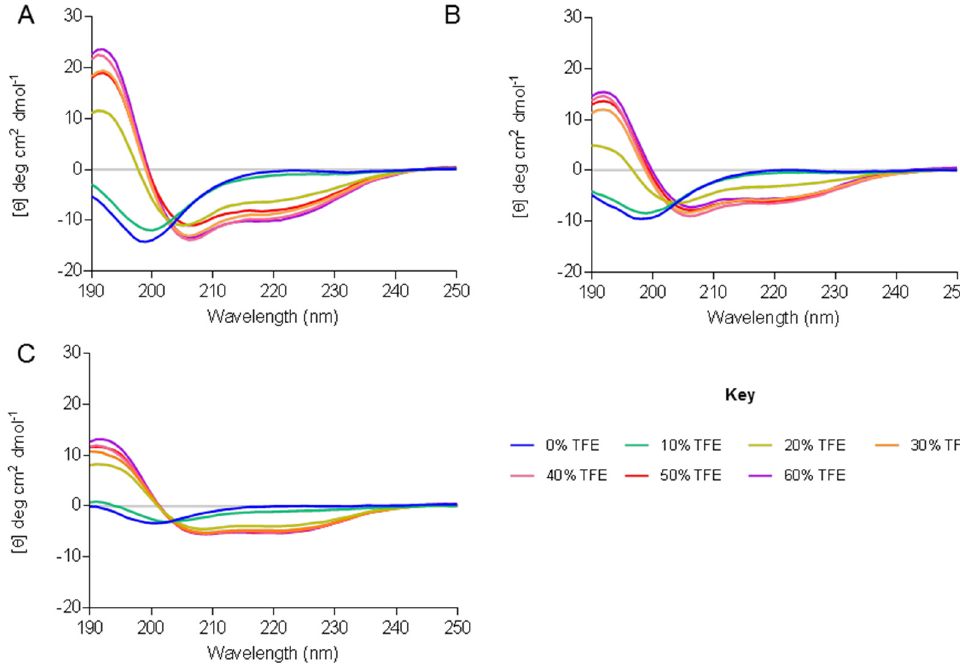
Figure 3. Titration of TFE and its effect on secondary structure. TFE was titrated from 0% to achieve a final concentration of 60% TFE. CD spectral traces for Smp24 ( A ), Smp24 S3K ( B ) and Smp24 K7F ( C ).